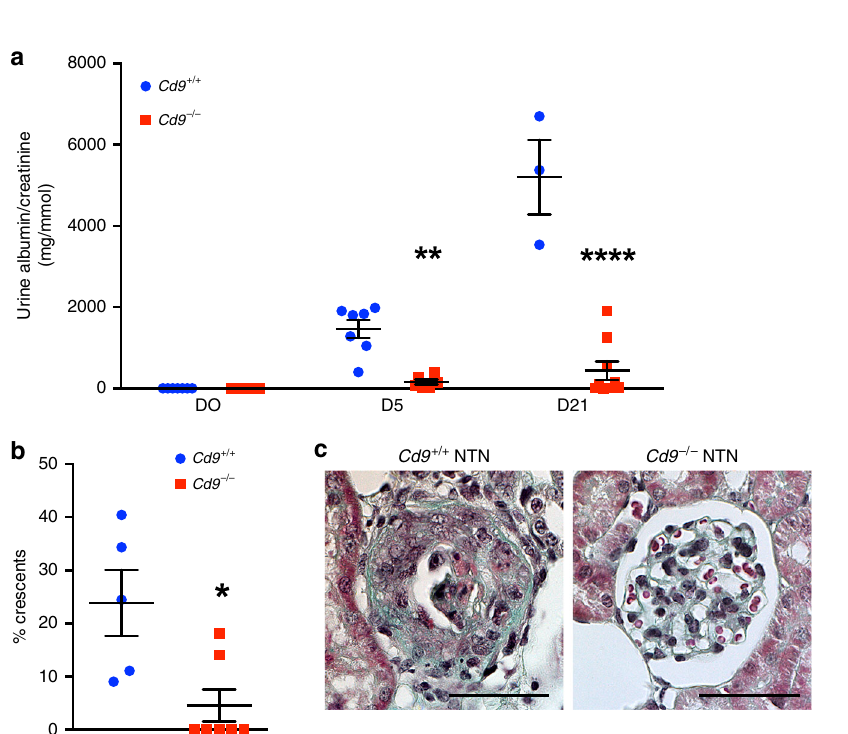
Fig. 2 global genetic CD9 depletion in mice protects from nephrotoxic serum-induced CGN. a Urine albumin-to-creatinine ratio in Cd9 − / − and Cd9 + / + mice at baseline and during NTN model. The data represent mean + / − s.e.m. of n = 7 and 9 mice at baseline, n = 6 and 9 mice at day 5 and n = 3 and 9 mice at day 21 (no Cd9 − / − but 7/10 Cd9 + / + mice had from end-stage kidney failure with 100% of crescentic glomeruli). Individual values are shown in dots. t test: ** P < 0.01; **** P < 0.0001 for Cd9 − / − vs . Cd9 + / + mice. b Associated quanti fi cation of the percentage of glomeruli with crescent formation. The data represent mean + / − s.e.m. of n = 5 and 7 mice per group. Individual values are shown in dots. t test: * P < 0.05. c Representative images showing Masson ’ s trichrome staining on kidney sections from Cd9 − / − and Cd9 + / + mice 10 days after nephrotoxic serum injection (NTN). Scale bar: 50 µ m. Source data are provided as a Source Data fi